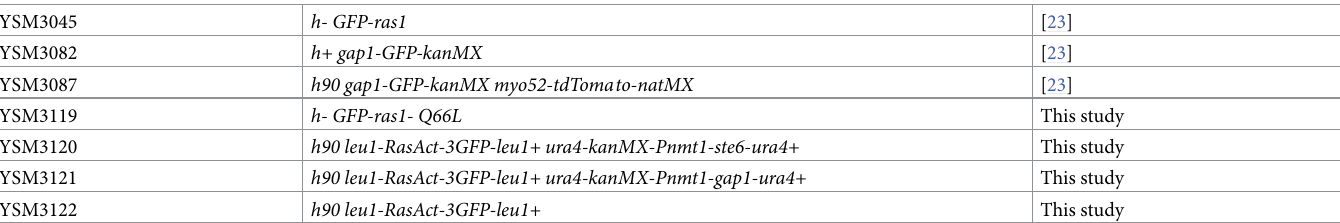
Table 2. Strains used in this